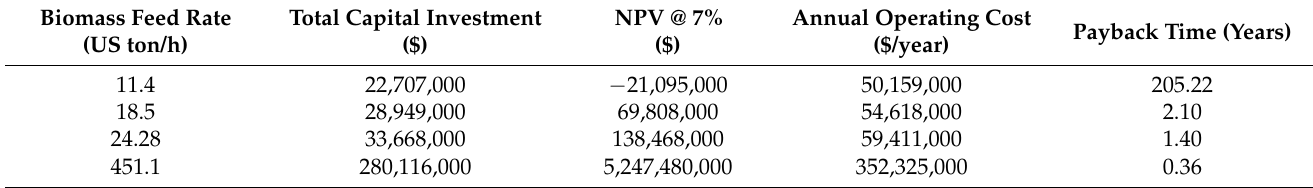
Table 11. The effect of biomass feed rate and city size on the process economics of each MixAlco facility. Biomass Feed